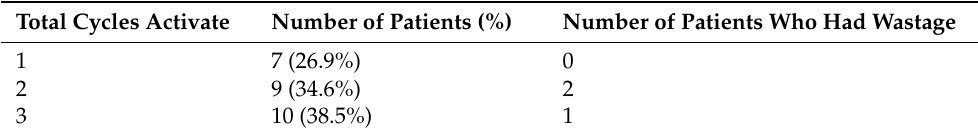
Table 1. Wastage according to the number of cycles activated.